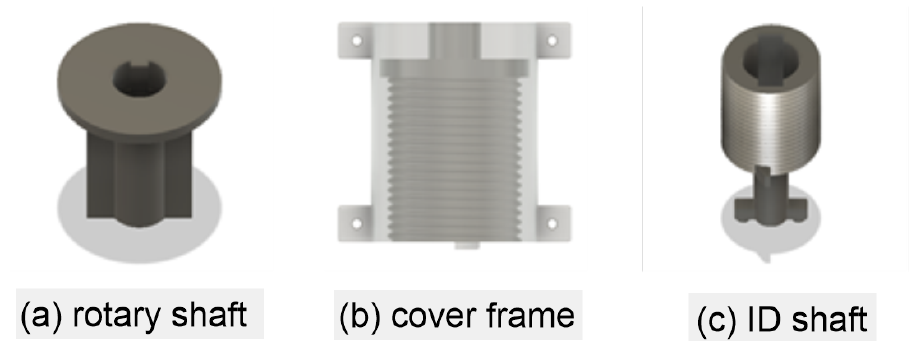
Figure 5. The models of ( a ) the rotary shaft, ( b ) the cover frame, and ( c ) the ID shaft. The rotary shaft and ID shaft are installed inside the cover frame. The ID shaft moves up and down inside the cover frame. The ID shaft generates the ID’s vertical motion from the motor’s rotational motion.